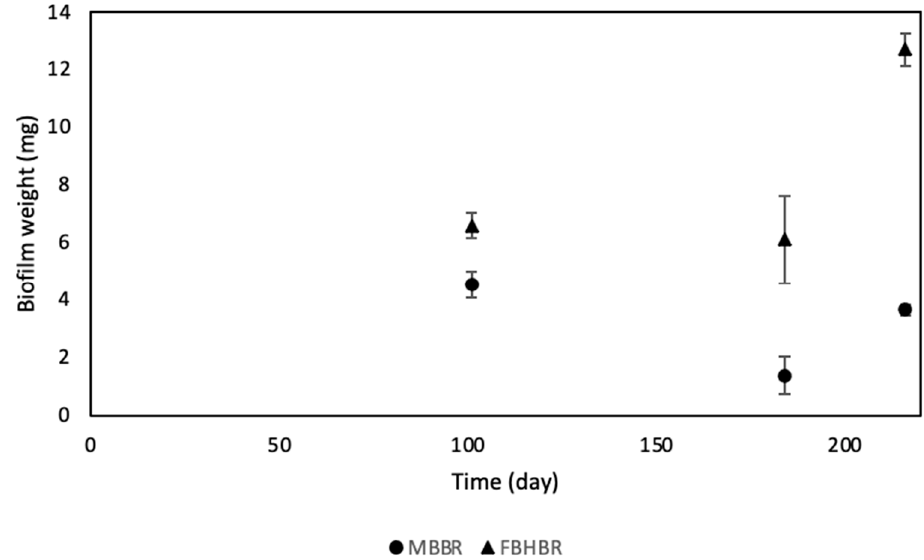
Figure 4. Evolution of biofilm weight in both MBBR and FBHBR during the process operation.